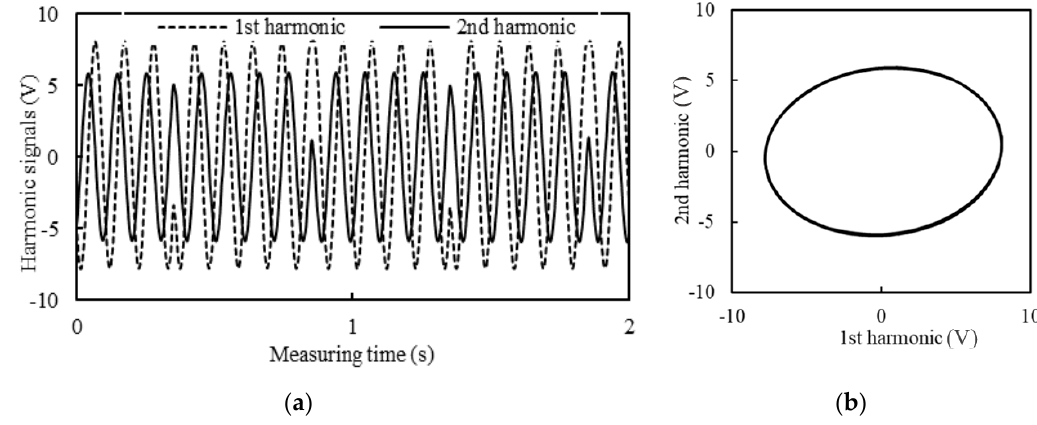
Figure 7. First and second harmonics detected by the lock-in amplifiers (LIAs) ( a ) and illustrated in a Lissajous diagram ( b ).